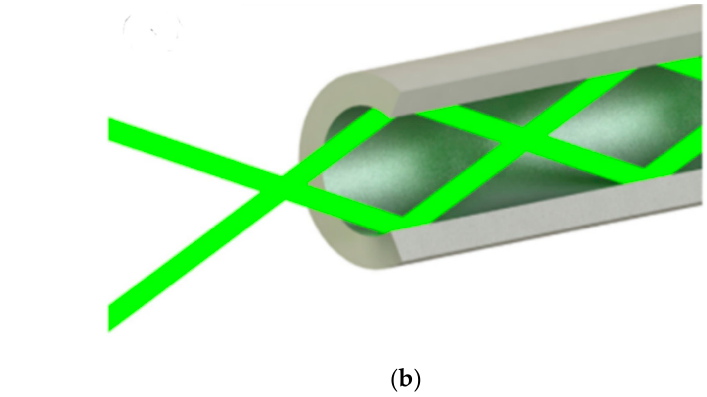
Figure 12. ( a ) Experimental setup for the collection of MCC Raman scatter. ( b ) Comparison of ex- perimental results of H 2 in air and MCC. Reprinted with permission from [69] © The Optical Society. In addition, the detection of Raman light in MLHCF needs to consider the effects of fluorescence and background light. The laser optical components and HCF will produce fluorescence, which affects the shot noise of the background spectrum and reduces the signal-to-noise ratio, thereby affecting the detection limit. The most straightforward method can reduce the fluorescence by reducing the number of optical devices, while pre- venting the spectrometer from receiving the fluorescence from the glass layer. In addition, Okita et al. [70] covered the end face of the HCF, and Mullen et al. [71] coated the end face of the HCF with a layer of silver, which not only prevented the laser from entering the HCF from the end face, but also prevented the glass fluorescence from being received by the spectrometer. In addition, the imperfect optical coupling and transmission loss of the optical fiber will cause background signals to be generated, causing great problems for trace detection. Rupp et al. [72] studied how to improve the Raman detection limit by reducing the fluorescent background of the MLHCF. The longer the wavelength of the